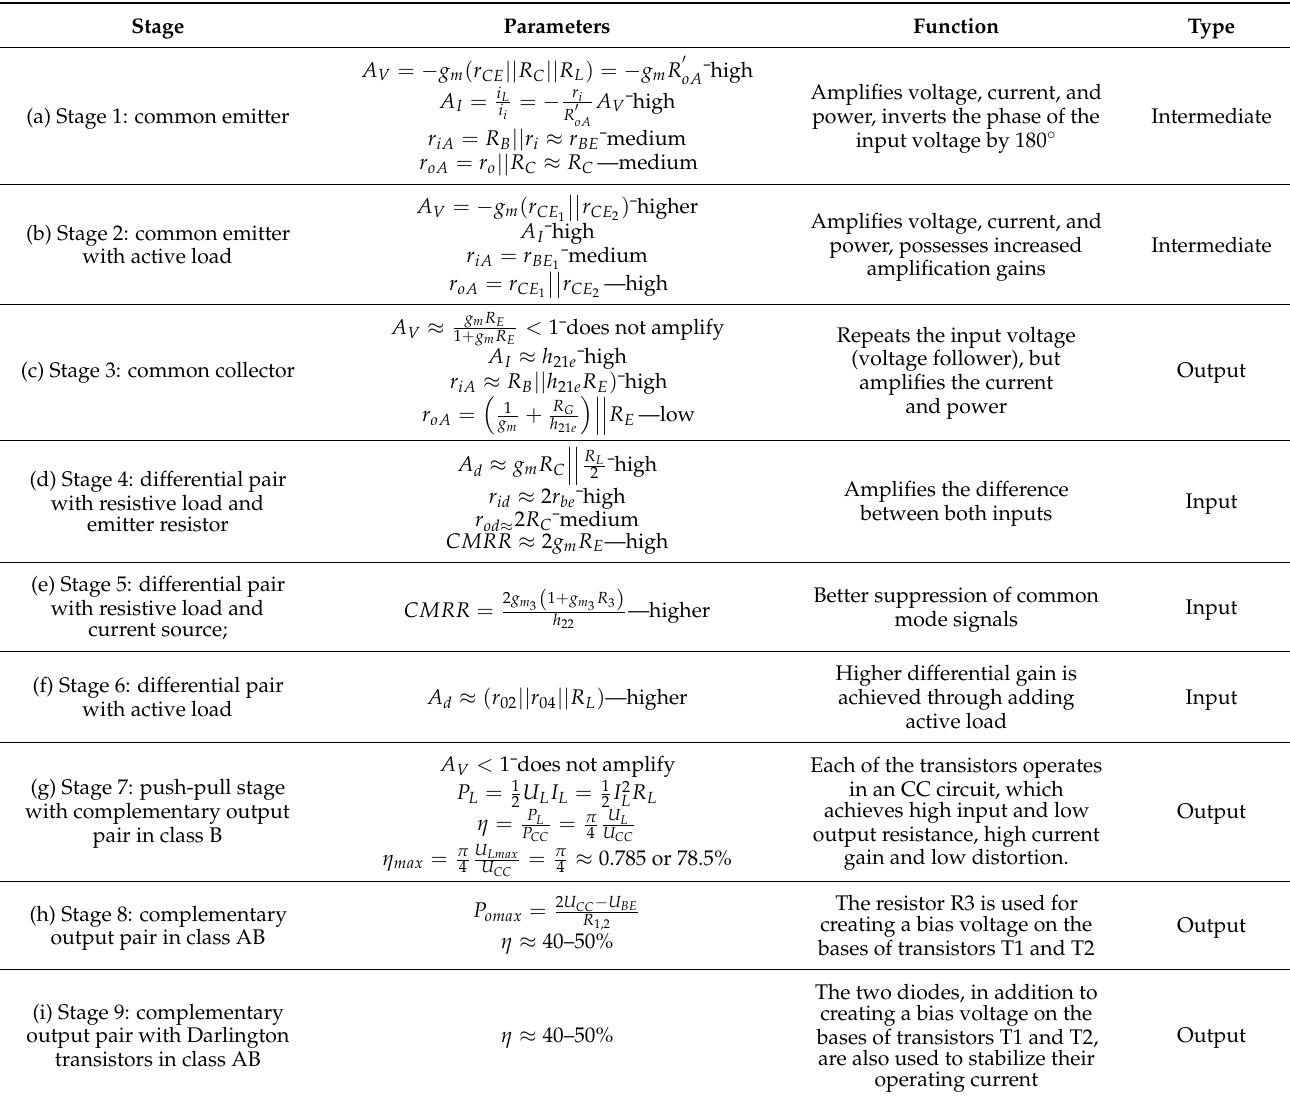
Table 1. Parameters of amplifier